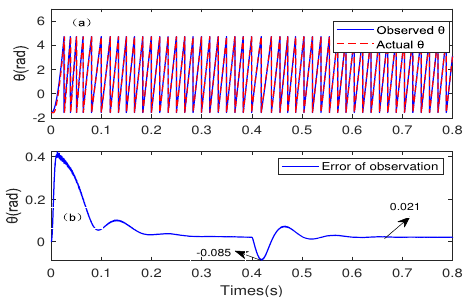
Figure 27. The estimation of rotor position Angle using PI. ( a ) Observed and actual rotor position Angle. ( b ) Rotor position Angle observation error.